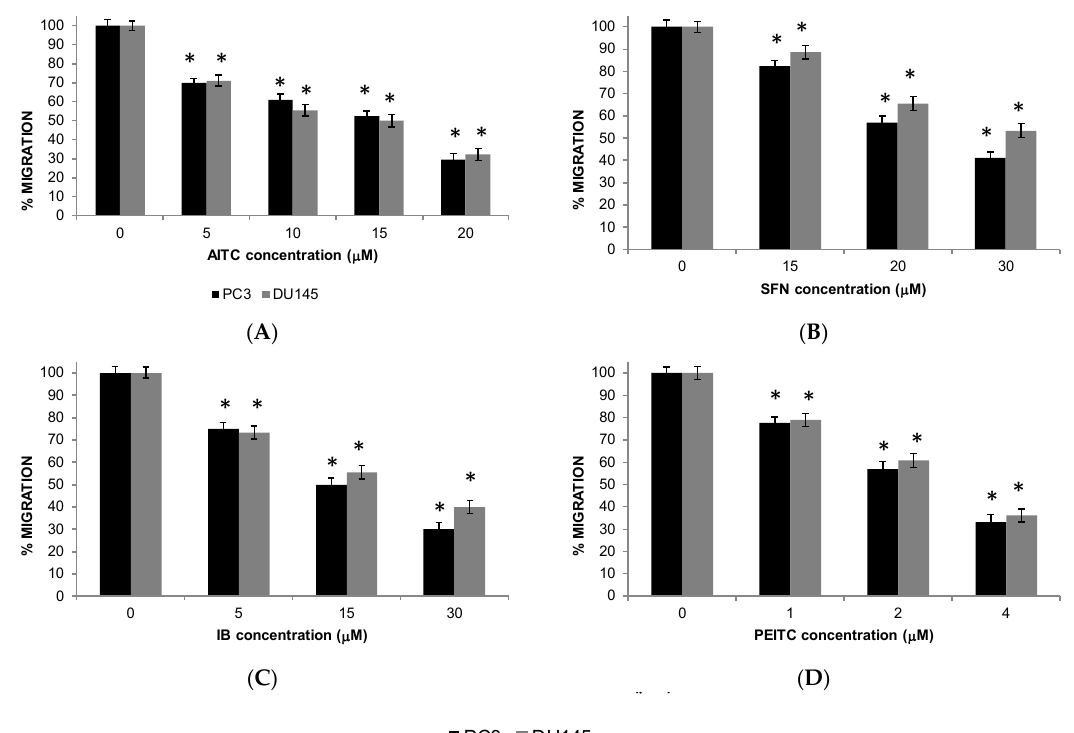
Figure 5. Isothiocyanates inhibit PC-3 (black pillar) and DU 145 (grey pillar) cell migration. Prostate cancer cells were treated with allyl-isothiocyanate (AITC), sulforaphane (SFN), iberin (IB), and phenethyl-isothiocyanate (PEITC). Data are shown as the mean ± SD of three independent experiments. * Isothiocyanate treatment significantly different compared with control treatment ( p < 0.05).